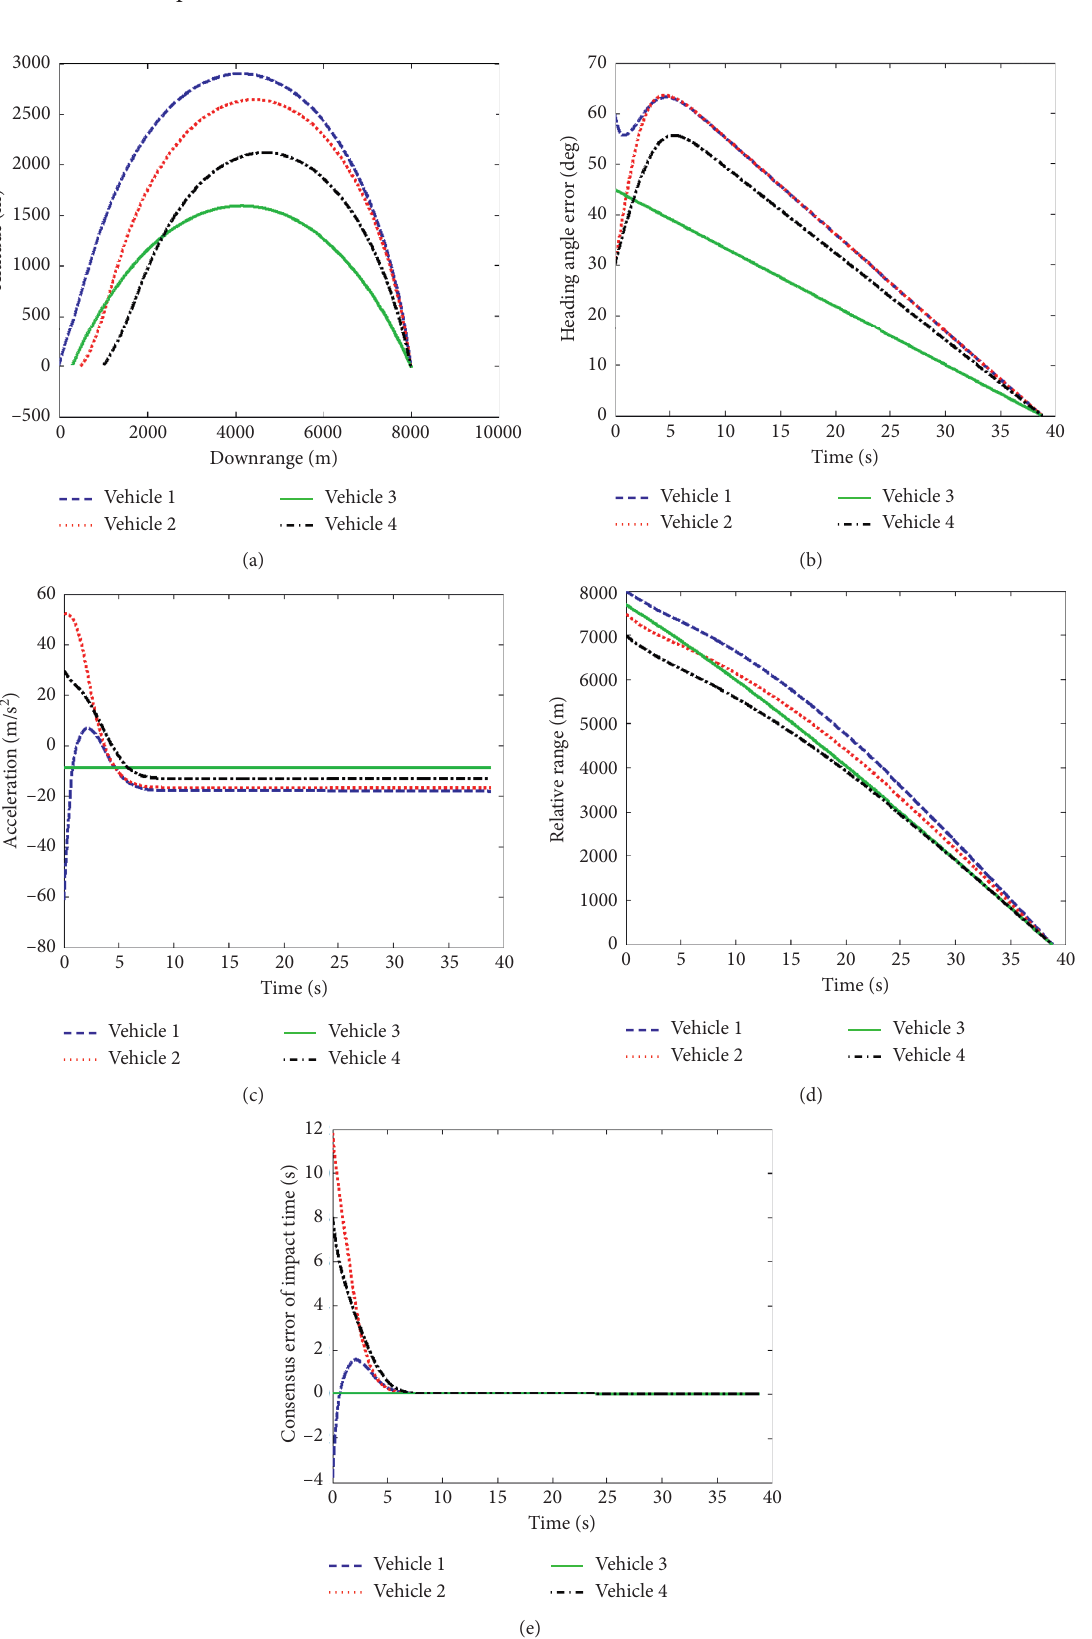
Figure 5: Simulation results under leader-follower communication topology. (a) Vehicle trajectory. (b) Heading error. (c) Lateral ac- celeration. (d) Range variation. (e) Consensus error of flight